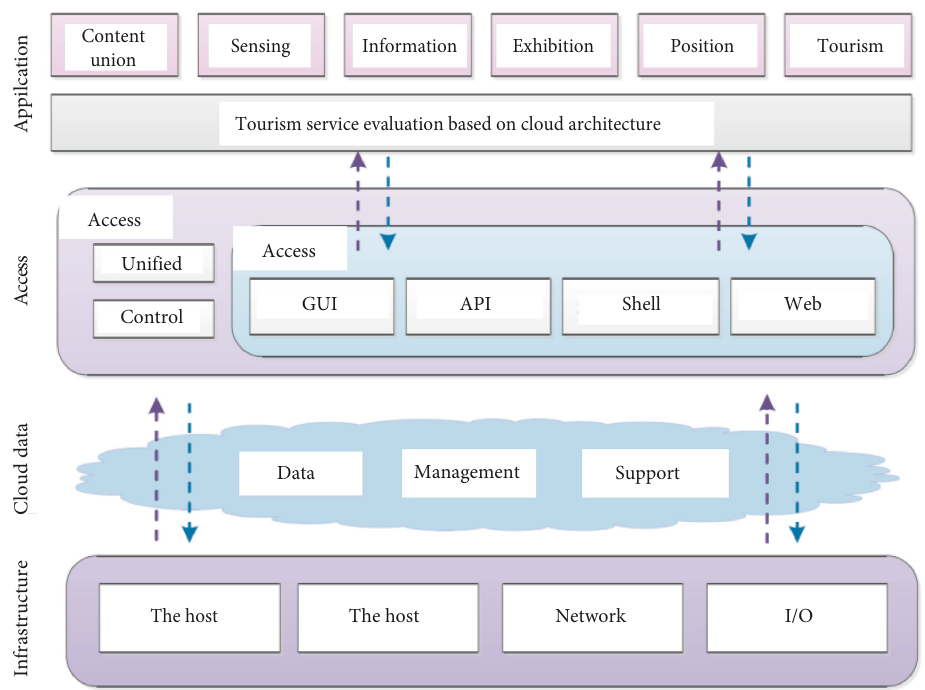
Figure 2: Performance evaluation framework of rural tourism public